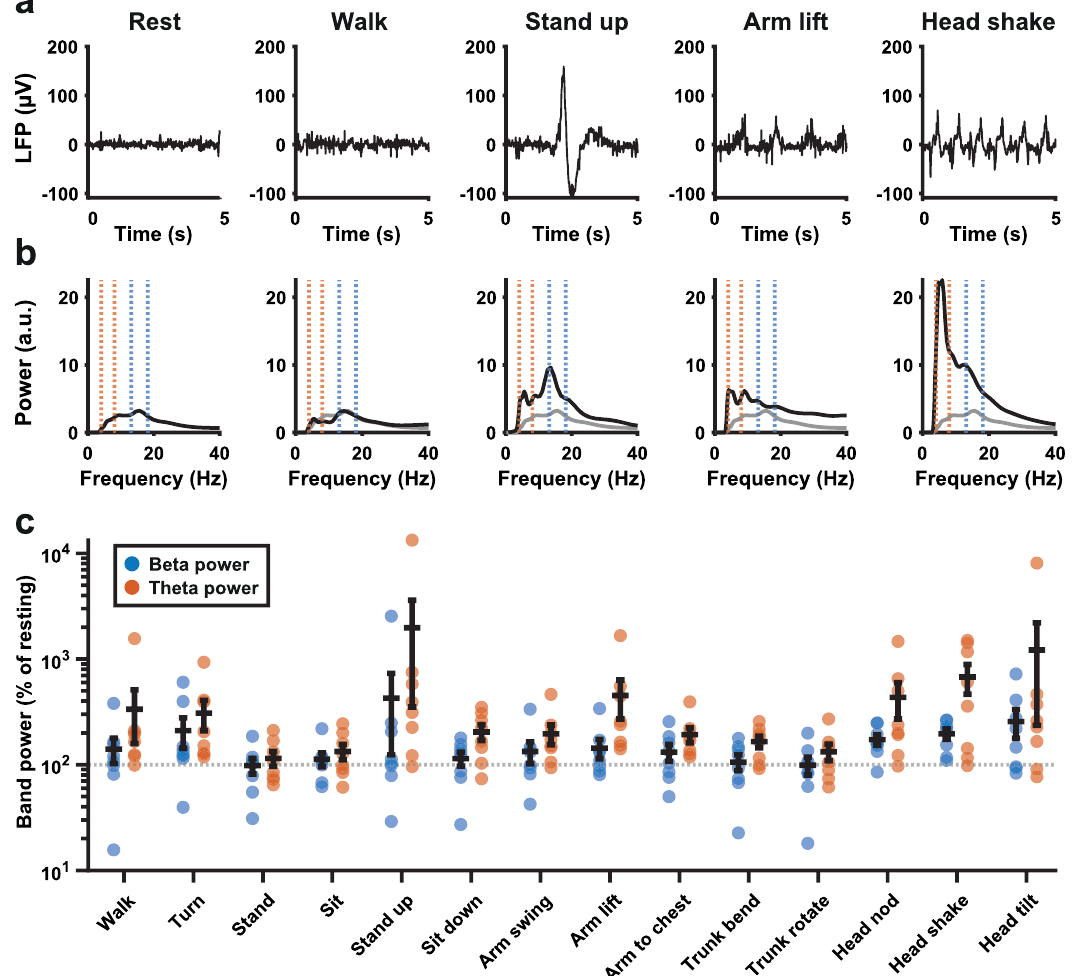
Fig. 4 Common movements and their impact on measures of beta and theta band power. a Five-second LFP recordings from the STN of one patient collected with DBS on while they were resting, walking, standing up from a sitting position, making a winging motion with the arms, or shaking the head after application of a low-pass fi lter at <98 Hz and high-pass fi lter at >4 Hz. b Global wavelet power spectra (arbitrary units) corresponding to the LFP collected during the events depicted in a . Blue dotted lines indicate the beta peak window for this STN and orange dotted lines indicate the theta band. The resting spectrum on the left is replicated as a gray line across the other spectra for comparison. c Beta (blue) and theta (orange) band power measures as a percentage of resting power, from LFPs collected during a series of different movements (see Table 2 for all absolute and relative values; n = 8 STN LFPs from four patients). The beta band was de fi ned as 5 Hz around the STN-speci fi c beta peak, while the theta band was 4 – 8 Hz for all